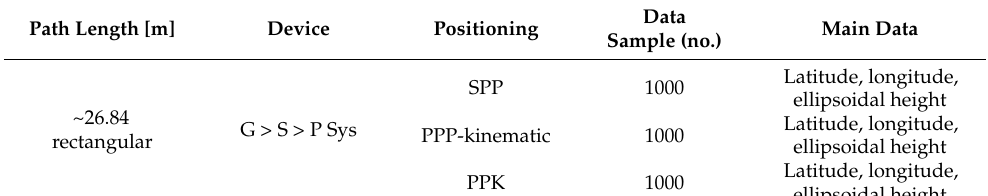
Table 5. Dynamic datasets composition of the pool test.